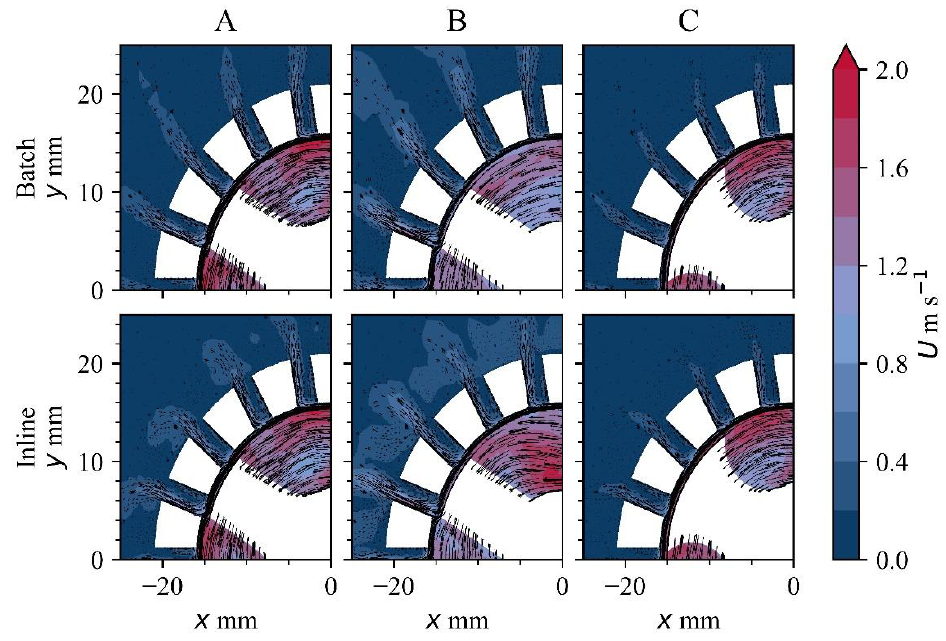
Figure 4. Quarter plot of the velocity contours along the plane z = 13 mm, zooming onto the rotor–stator mixer and surrounding area. The arrows represent the direction of the flow field.